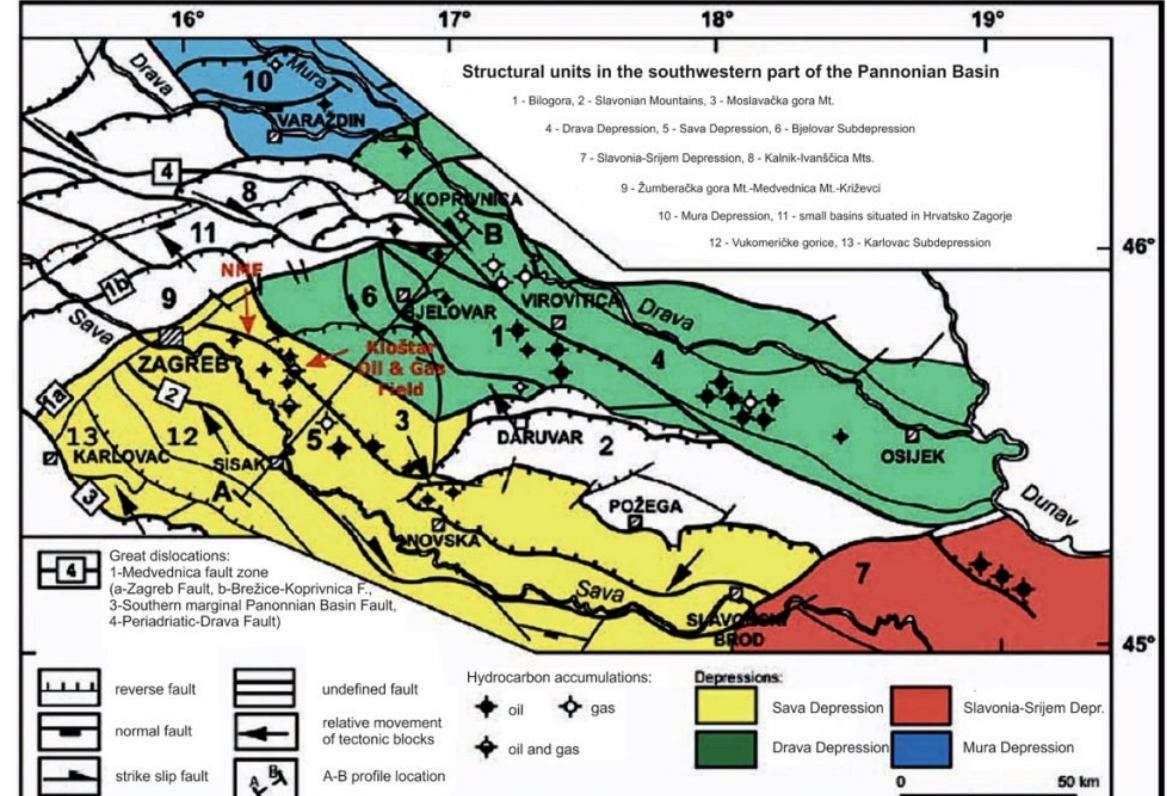
Figure 5. Main structures and fault systems in the CPBS, with position of hydrocarbon accumulations (modified after [100]).